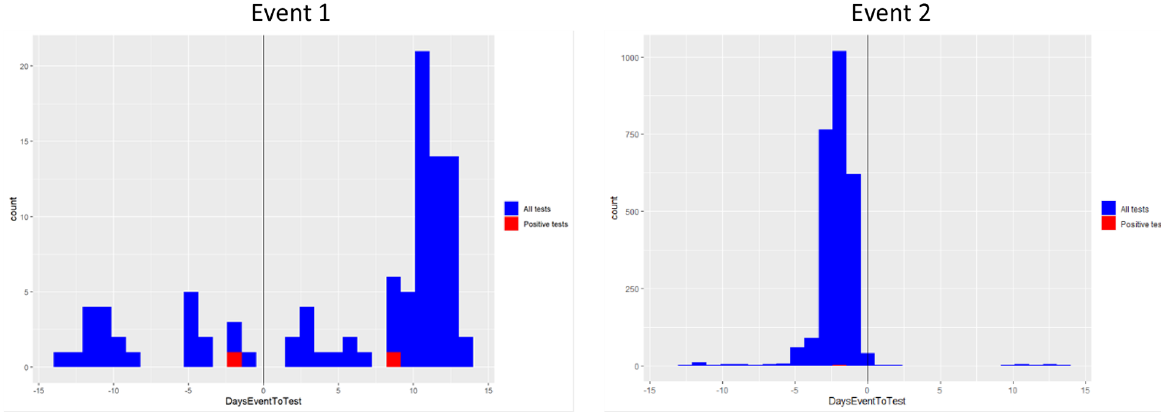
were found for test events 1 and 2, respectively,